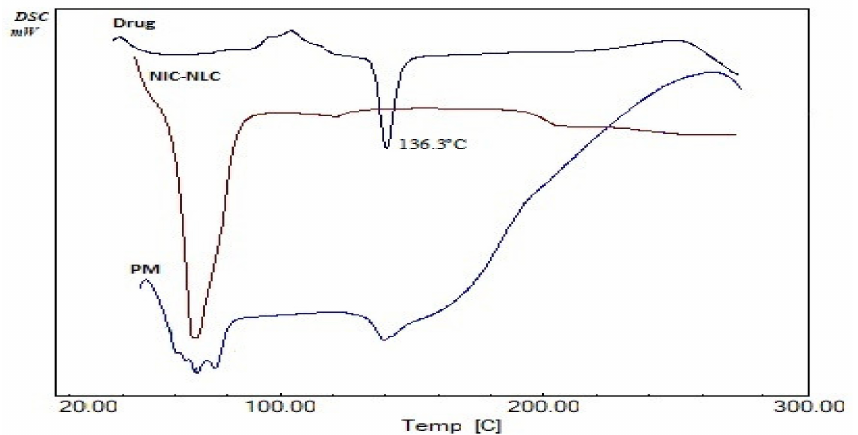
Figure 4. DSC thermograms of NIC (drug) compared to optimized NIC–NLC formula and physical mixture (PM) of formula